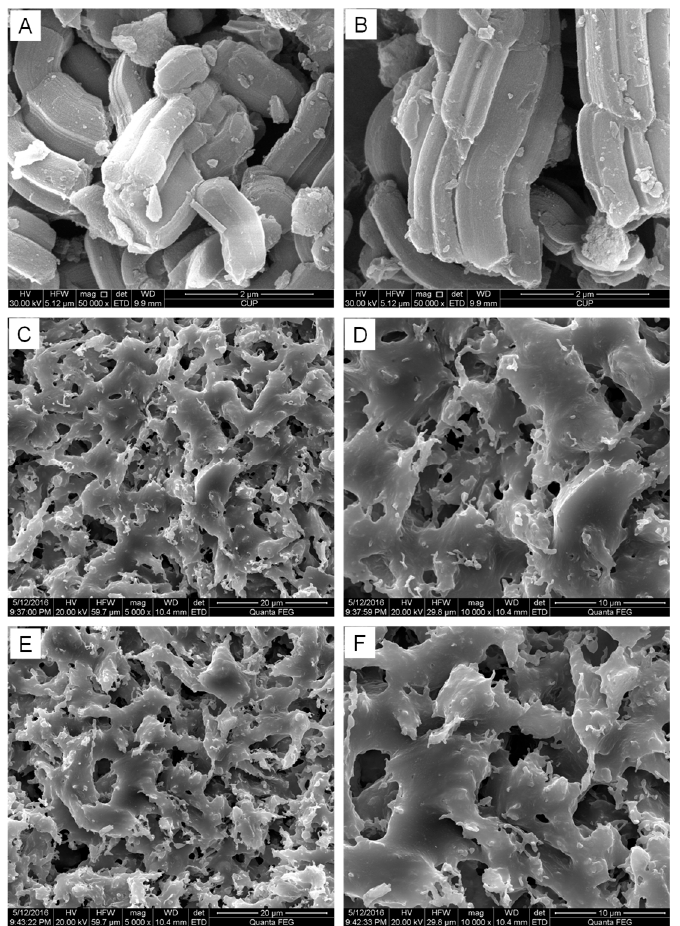
Figure 1. The SEM images of the materials, PtAu/carbon ZSBA ( A ) and Pt/carbon ZSBA ( B ) after calcination; PtAu/3D carbon ( C , D ) and Pt/3D carbon ( E , F ) after SiO 2 leaching.